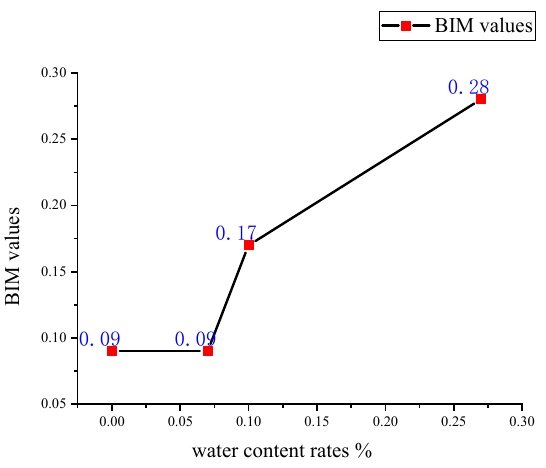
Figure 10. BIM values of limestones with di ff erent water content rates.